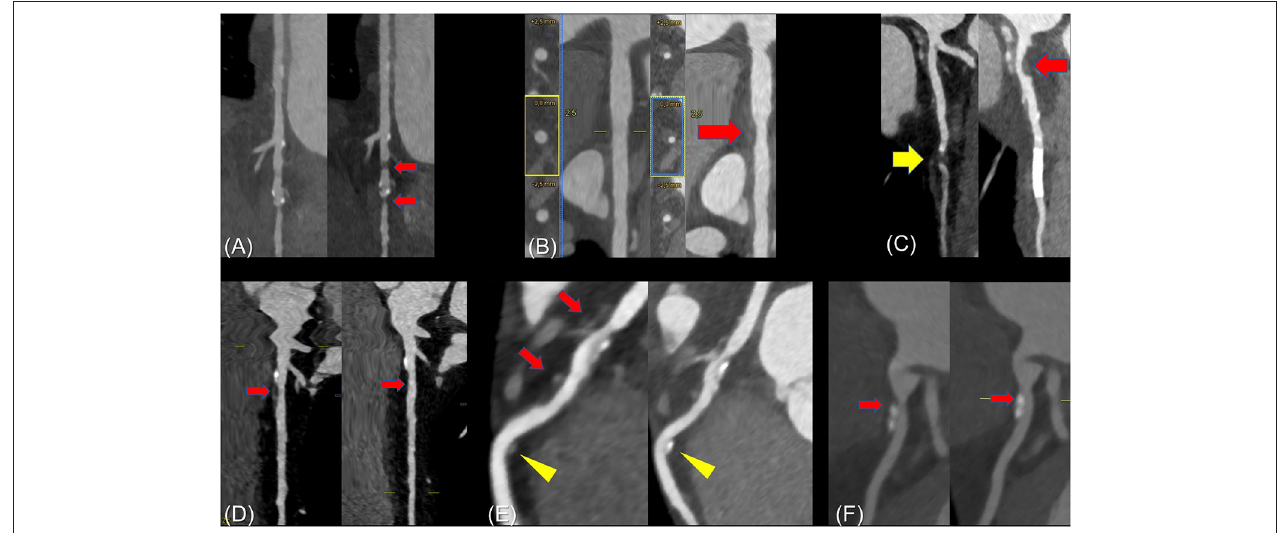
FIGURE 3 | Examples of progressive and regressive plaques. (A) Rapidly progressive CAD with the occurrence of two significant plaques in the distal LCX within a period of 14 months. (B) Initially, only slight irregularities of the proximal LCX were found. Statin therapy was rejected by the patient. As a malignant thymoma was incidentally found at the combined coronary and thoracic CT examination, the patient underwent radiotherapy, which contained the proximal LCX in the radiation field. In the follow-up CTA examination after 18 months, a non-calcified plaque with a lumen narrowing of ≈ 50% was found in the LCX with a new inflammatory border in the perivascular fat tissue (arrow). (C) The initial coronary CTA showed a short-length closure of the LAD segment 7 (yellow arrow) and slight wall irregularities proximally. The follow-up examination after 44 months demonstrated an open coronary artery stent and a significant progression of atherosclerosis with a new non-calcified plaque in the proximal LAD segment 6 (red arrow). (D) Initially, the proximal LAD showed calcifications with an adjacent non-calcified plaque with negative remodeling resulting in a mild stenosis. After 18 months of intensified statin therapy, almost complete regression of the vulnerable plaque with only slight wall irregularities of the vessel wall was observed. Of note, even the soft hem around the proximal calcification was not detectable any longer. (E) The predominantly non-calcified plaque (red arrows) with positive remodeling and fibrous cap diminished clearly in the follow-up coronary CTA after 36 months of statin therapy. The distal non-calcified plaque (yellow arrows) almost calcified completely. (F) The initial examination showed a dumbbell-like calcification with surrounding soft tissue cover (arrow) of the LAD. After statin therapy for 24 months, an increasing calcification was detectable and the apical non-calcified plaque did not longer appear. The vessel area increased from 2.9 mm ² to 3.8 mm ²